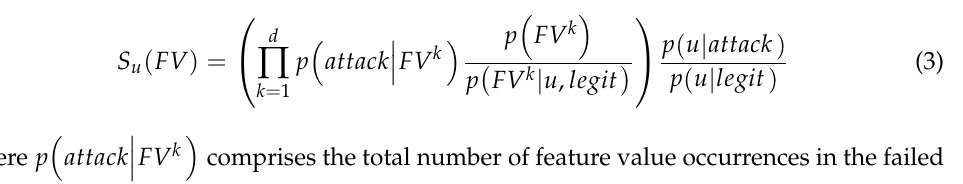
Figure 3. An example of useragent string when using Internet Explorer 11.0 (i.e., Mozilla: MozillaProductSlice, this is only used for historical reasons; 5.0: Mozilla version; Windows NT 10.0: Operating System; WOW64 (Windows-On-Windows 64-bit). A 32-bit application is running on a 64-bit processor; Trident: Layout engine for the Microsoft Windows version of Internet Explorer; 7.0: Trident version; rv:11.0: Browser version).